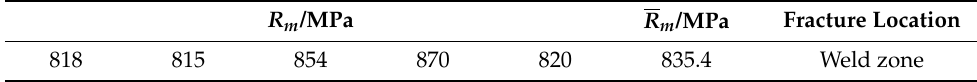
Table 7. Tensile properties of the swing-arc welded joints.